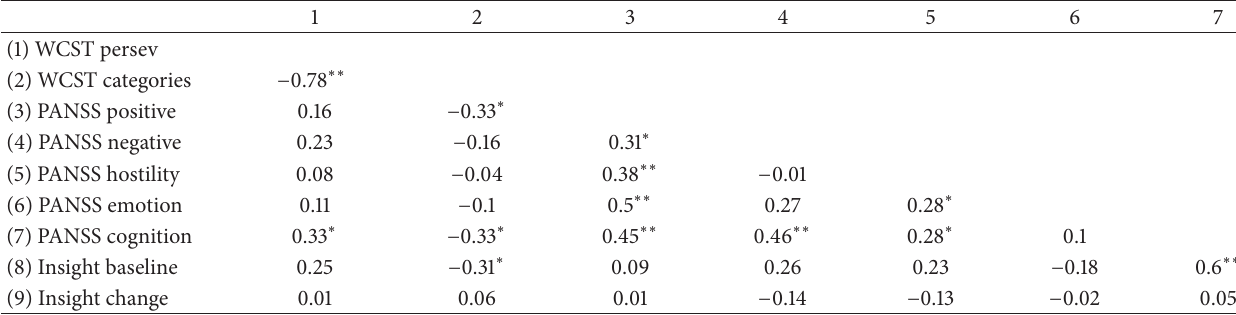
Table 1: Correlation matrix of neurocognition, insight, and clinical